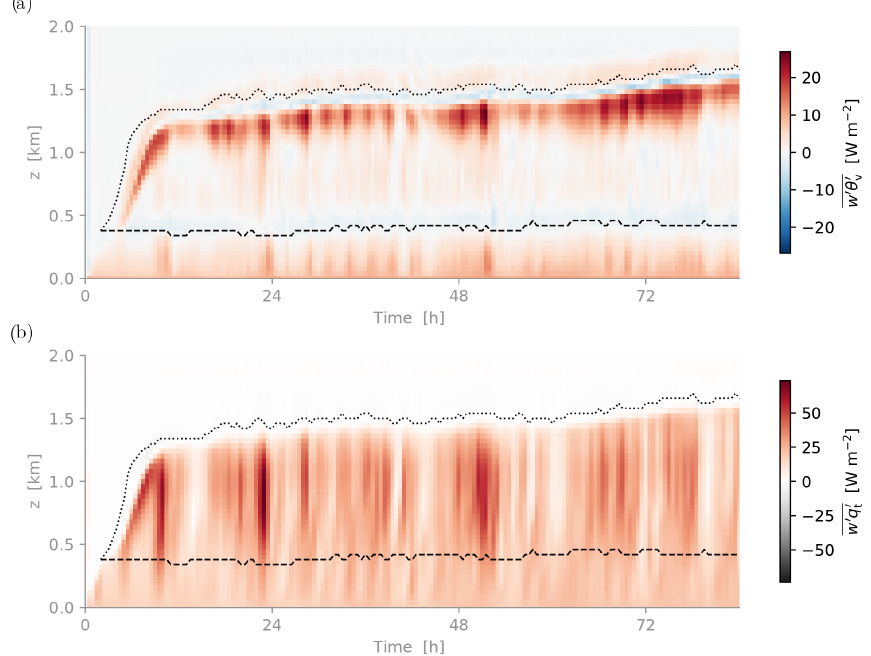
Figure 6. Same as Fig. 5 but now showing (a) the turbulent θ v flux and (b) turbulent q t flux.